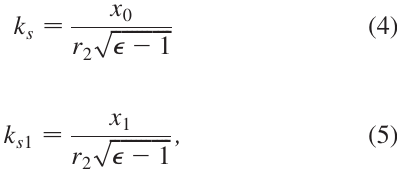
ffiffiffiffiffiffiffiffiffiffiffiffi p (cid:2) (cid:1) 1